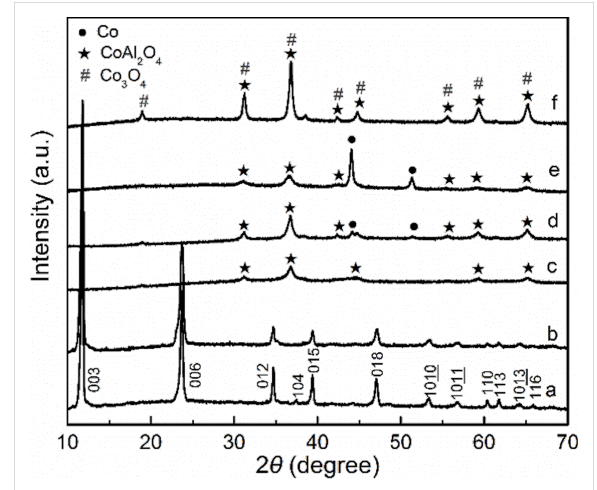
Figure 1: XRD patterns of: (a) pure CoAl LDH; (b) LDH@PDA-2.5 composite; (c–e) the NPLs prepared by carbonization of LDH@PDA- 2.5 at 500, 650, and 800 °C for 2 h, respectively; (f) LDO (Co 3 O 4 and CoAl 2 O 4